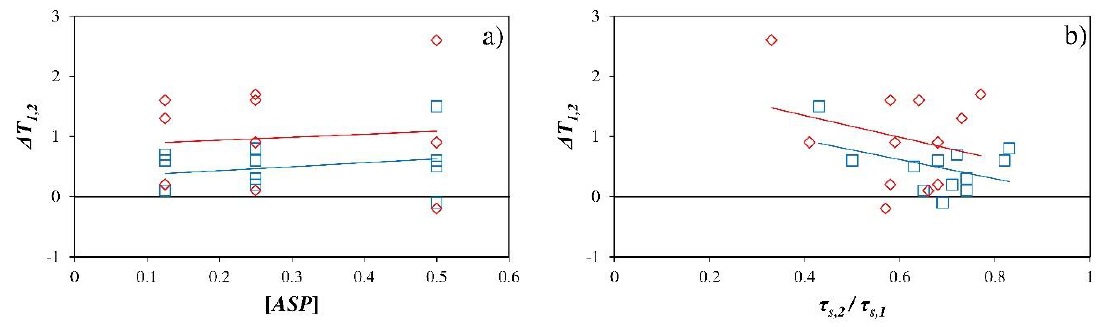
Figure 8. Mean values of temperature difference ΔT 1,2 [°C] between sector 1 (without ASP ) and sector 2 (with ASP ) as a function of the concentration of product applied [ ASP ] in [Kg l − 1 ] ( a ) and the ratio τ s,2 / τ s,1 ( b ). τ s , transmissivity to solar radiation. Subscript: 1 , sector 1 (without ASP ); 2 , sector 2 (with